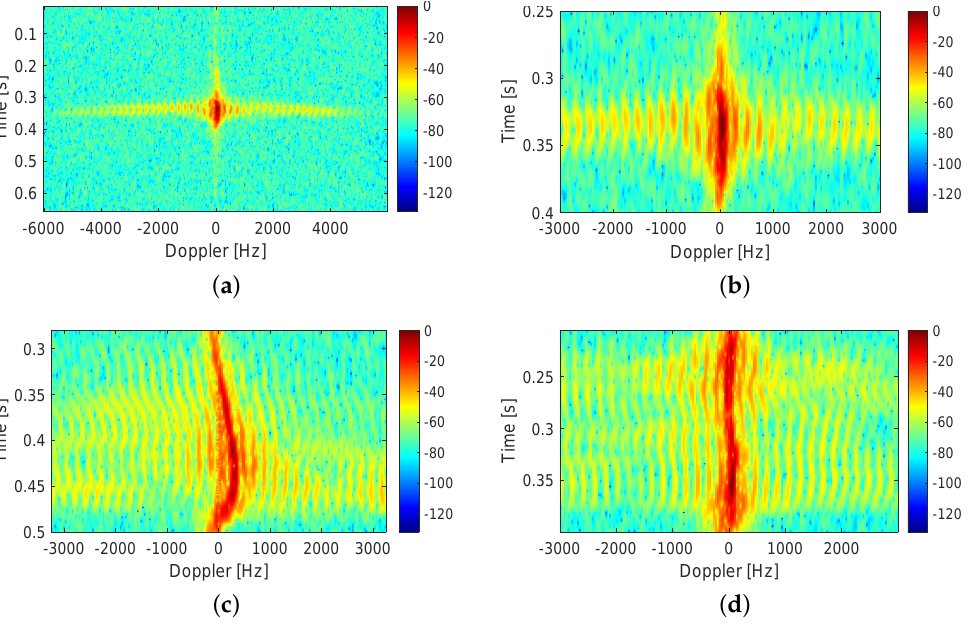
Figure 9. Results obtained from bee measurements. ( a ) Full spectrogram of the first measurement. ( b ) Excerpt of the spectrogram in Figure 9a. ( c ) Spectrogram of the second measurement. ( d ) Spectro- gram of the third